Question: What kind of plot is shown here?
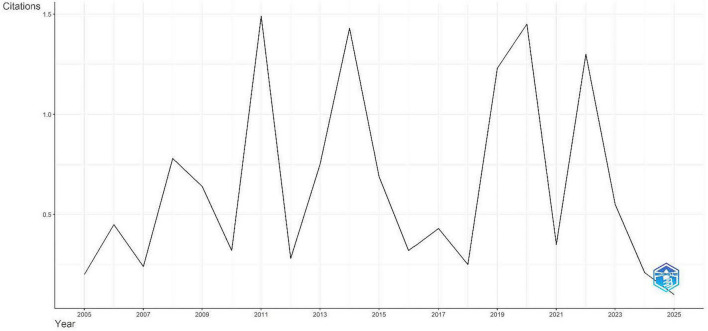
Answer: line